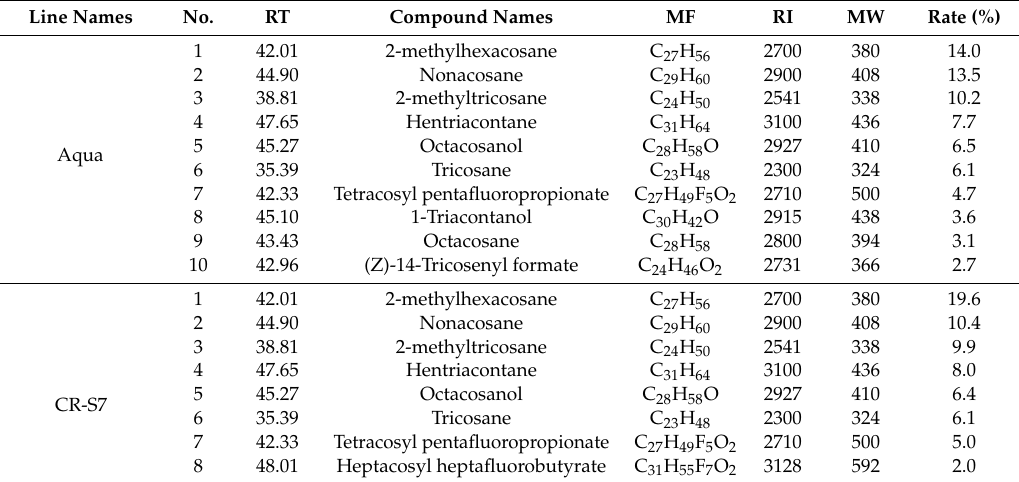
Table 2. Top 10 volatile compounds identified from the rose mutant and those of original